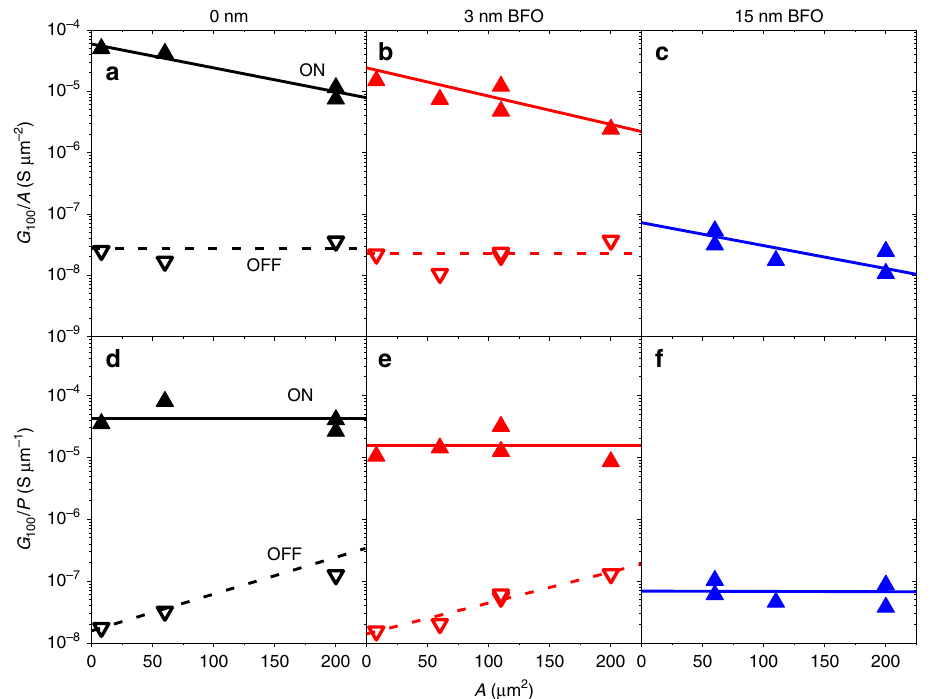
Fig. 3 Scaling of the conductance with the junctions ’ size. For a series of junctions with variable area A : a , b , c G 100 (3.2 K) in the ON and OFF states normalised by the junction area, G 100 / A ; and d , e , f G 100 (3.2 K) in the different states normalised by the junction perimeter, G 100 / P for the different samples. Lines are a guide to the